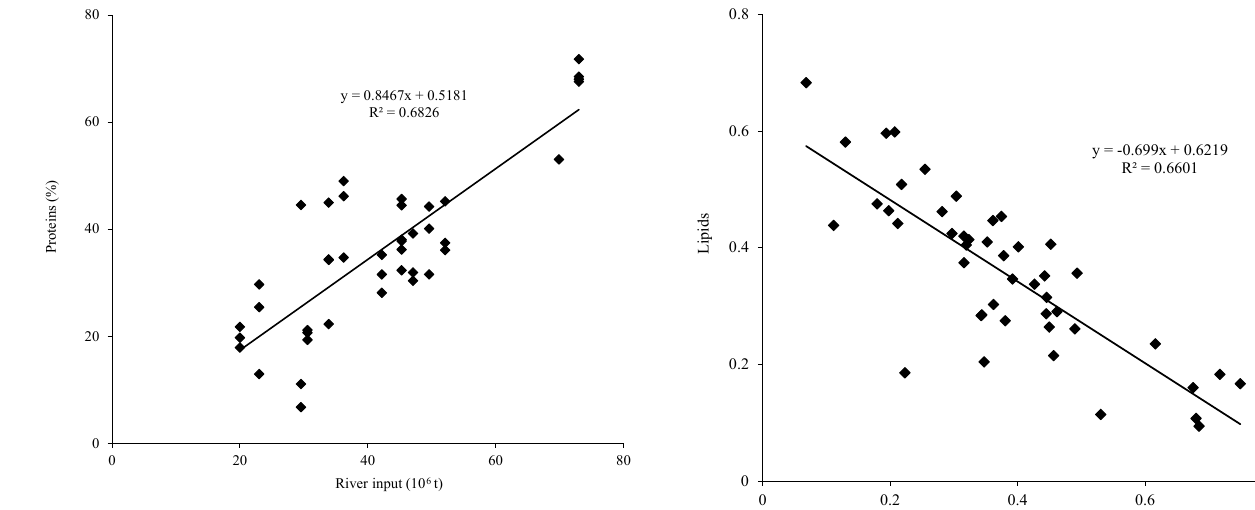
Figure 3. The positive relationship between river input and protein composition. River inputs were integrated from 20 days prior to our sampling dates.